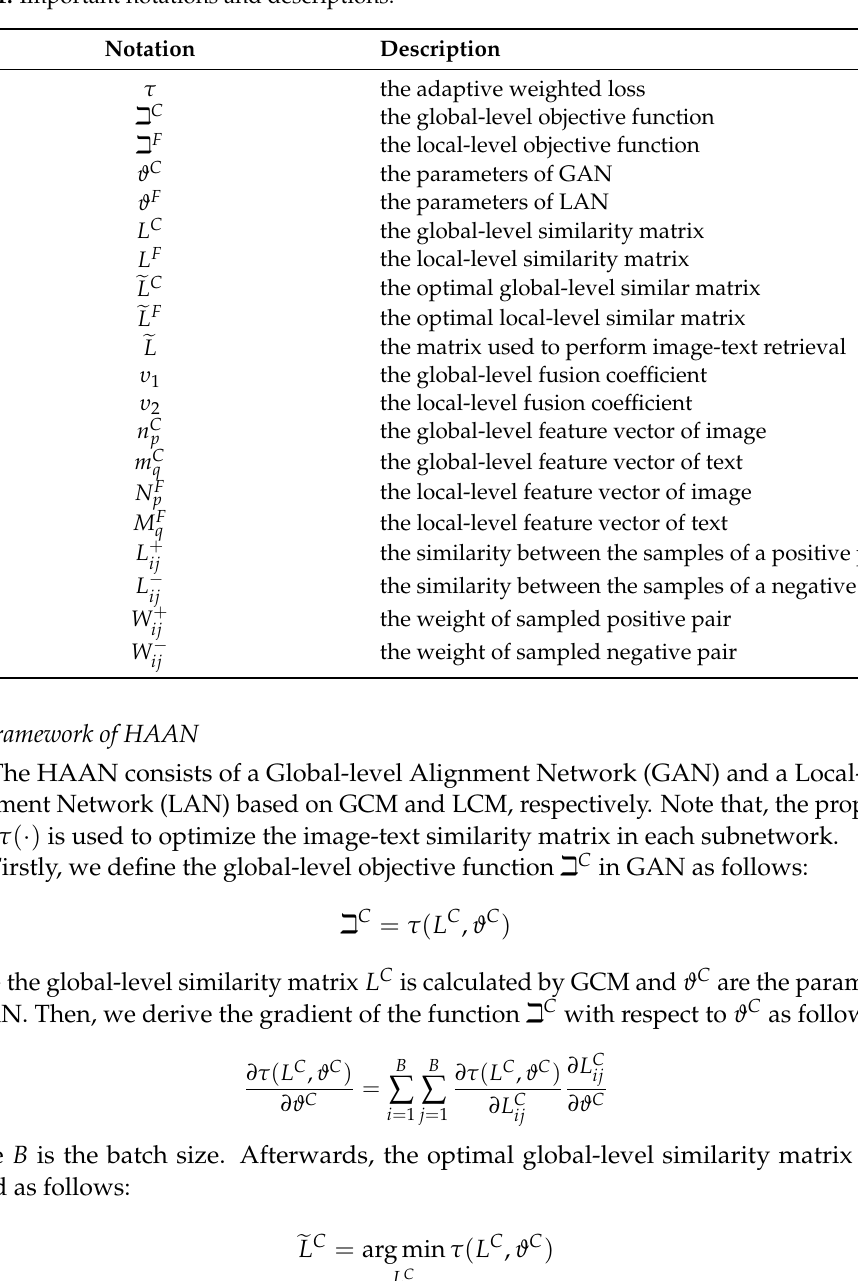
Table 1. Important notations and